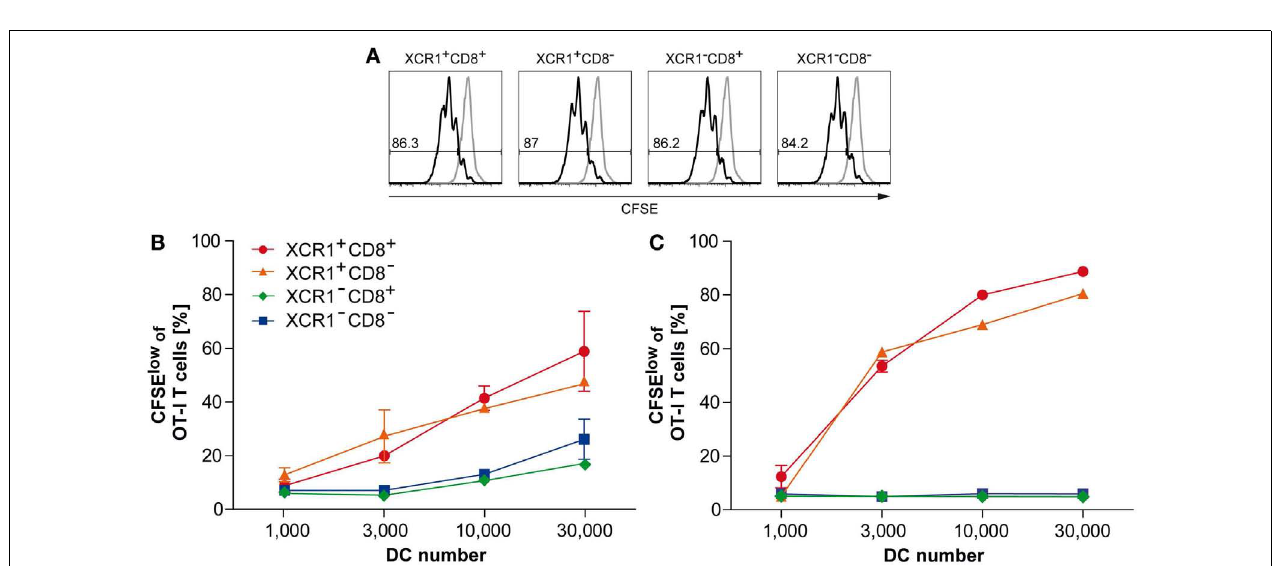
FIGURE 5 | XCR1 + DCs specifically take up cell-associated antigen. C57BL/6 mice were injected with 10 × 10 6 CFSE-labeled allogeneic 300-19- ∆ OVA cells i.v., and cDCs (CD11c + MHCII + Lin − cells) were analyzed for CFSE signals 2, 4, 12, and 24h later. (A) The XCR1 + CD8 + (red), XCR1 + CD8 − (only here black!), XCR1 − CD8 + (green), and XCR1 − CD8 − (blue) subpopulations are color-coded. Note that XCR + CD8 − DCs express lower